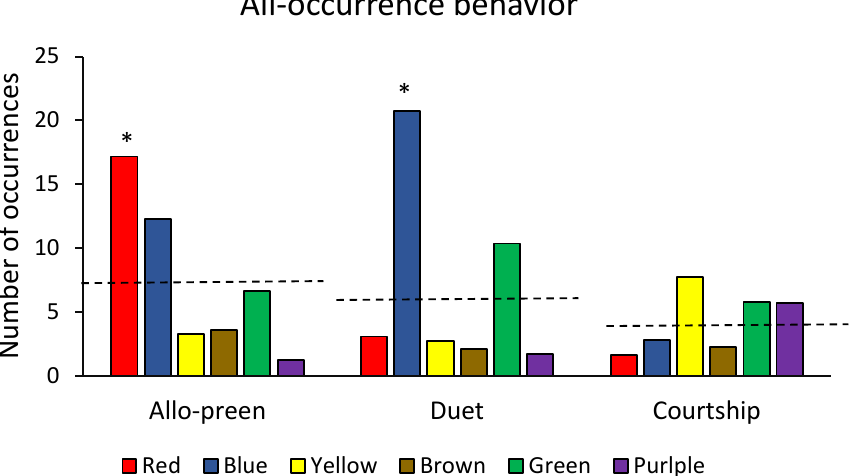
Figure 5. Frequency of pair-bonding behaviors across 6 mated pairs of Humboldt penguins based on 219 h of Zoo Monitor data. Frequencies were adjusted downwards by a factor of 11 to account for the differences in observation time across the two data collection systems. Dashed lines indicate the expected frequency of behaviors assuming no differences amongst pairs. * = p < 0.05. See text for details.